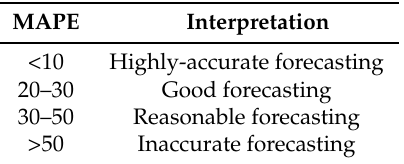
Table 4. Interpretation of typical MAPE values.